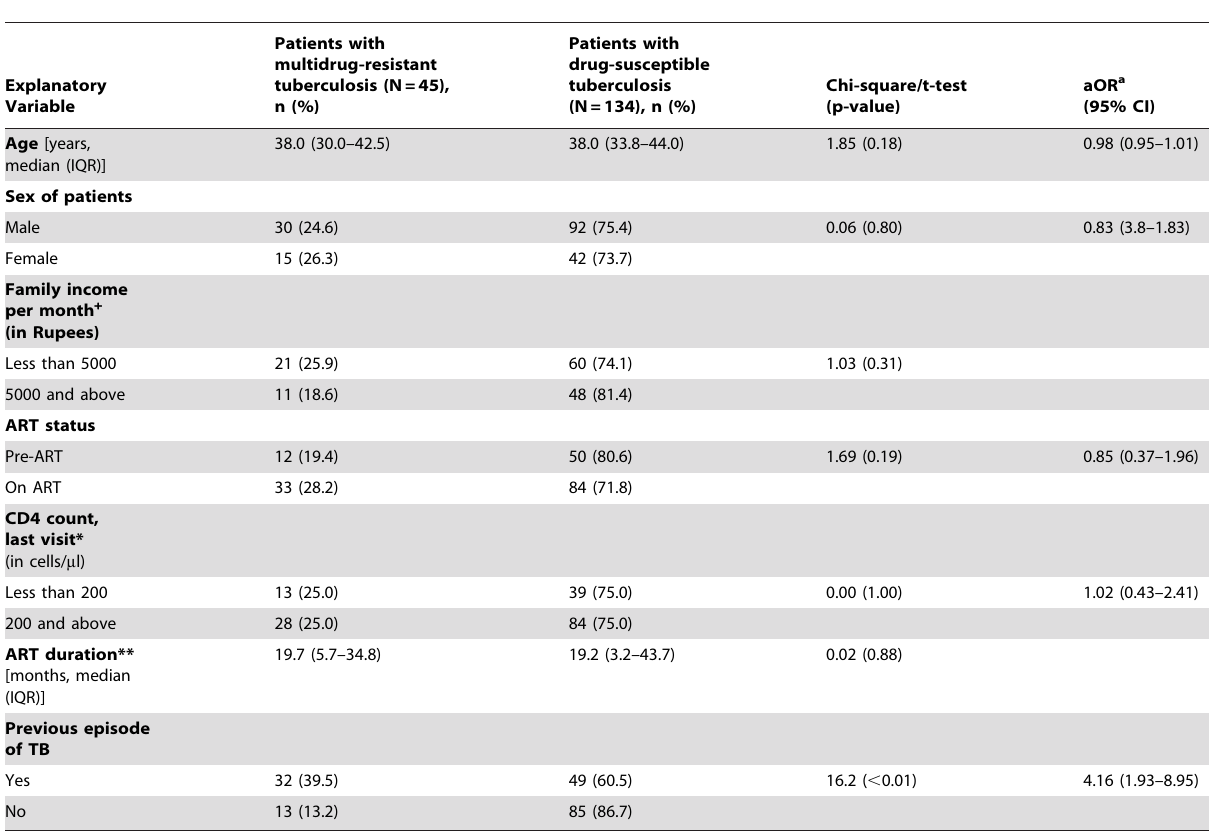
Table 5. Demographic and clinical factors associated with multidrug-resistant tuberculosis in HIV-infected tuberculosis patients, Mumbai,